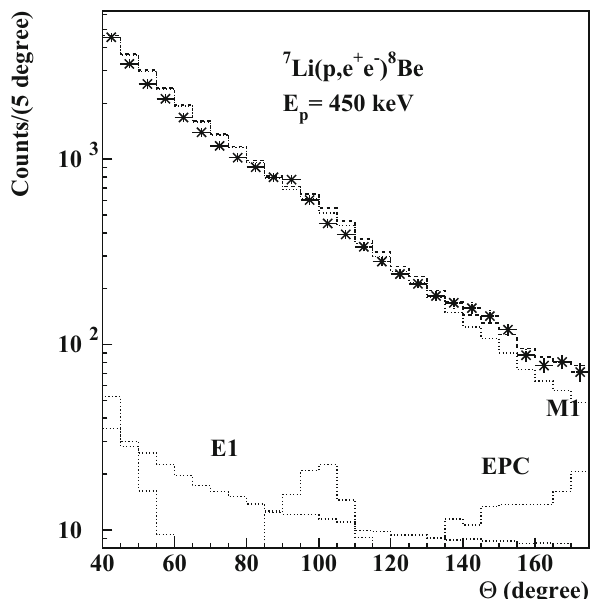
Fig. 4 e + e − angular correlations obtained for the 17.6 MeV transition of 8 Bebyusingathintarget(snowflakes).Theresultsofthesimulations performed for M1 and for E1 transitions as well as for the external pair creation(EPC)areindicatedasdottedhistogramsandtheirsum(dashed histogram) fitted to the experimental data are also shown